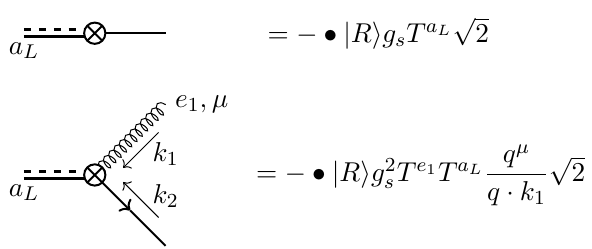
Figure 3 . Feynman rules of the first and second term of Wilson line operators under gluon-fermion h g − | ψ R ] -shift. The bullet • denotes a contraction with the fermion line emitting from Wilson line L operators. a L is the color index of shifted